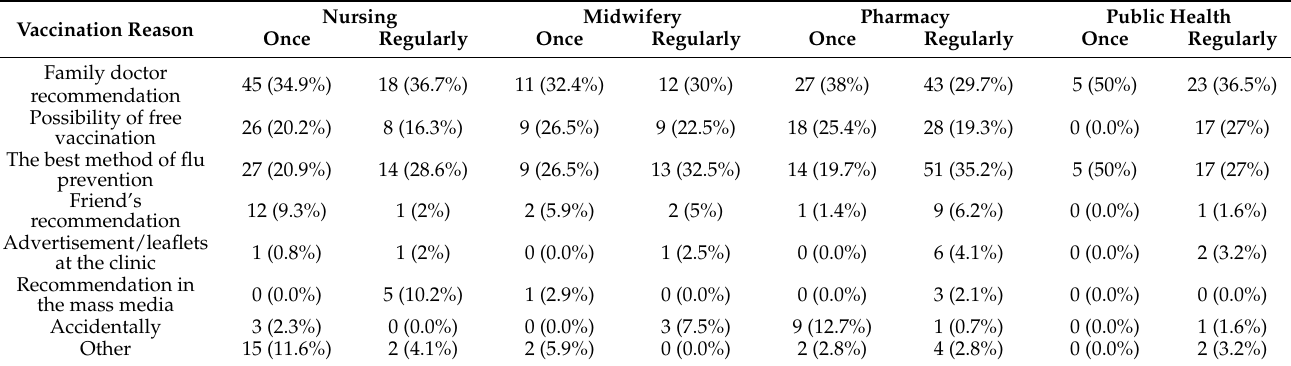
Table 2. Stated reason for vaccination among students, according to